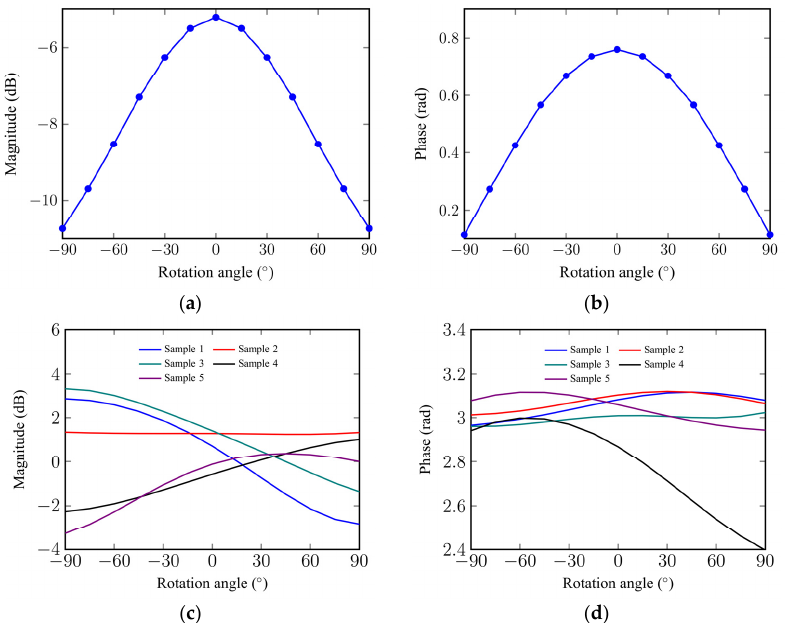
Figure 5. Variation of the transfer responses for virtual plants with human head rotation: ( a ) magnitude; ( b ) phase. The transfer responses between the virtual microphone locations and the physical microphone locations in the primary field: ( c ) magnitude; ( d ) phase.